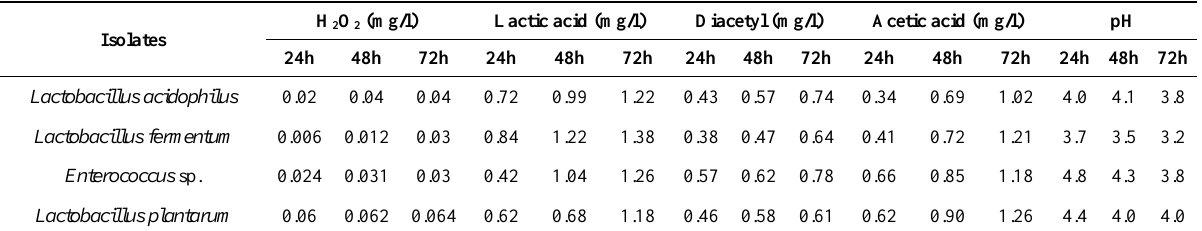
Enterococcus sp.